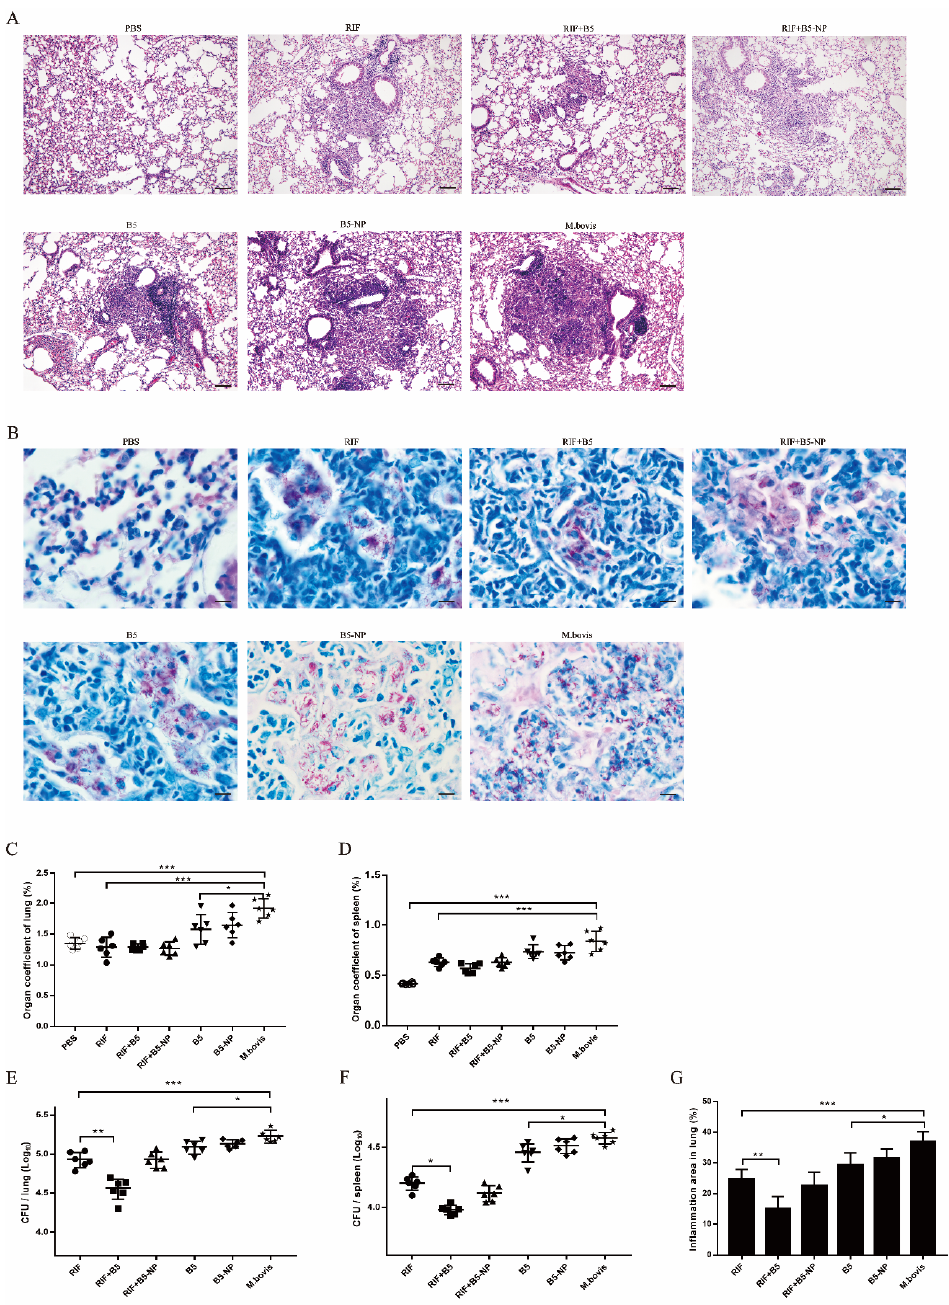
Figure 7. The therapeutic effect of B5 combined with RIF on M. bovis -infected mice. ( A , B ) Histopathological evaluation of lung tissues of M. bovis -infected mice was performed with H&E staining ( A ) and acid-fast staining ( B ) two weeks after treatment with B5, B5-NPs, or combined with rifampicin (RIF), respectively. The top panel ( A ) shows images at ×100 magnification (scale bars, 100 μ m); the bottom panel ( B ) shows images at ×1000 magnification (scale bars, 10 μ m). ( C – F ) The organ coefficient of lung ( C ) and spleen ( D ), and the number of viable bacteria in the lungs ( E ) and spleen ( F ) were determined 2 weeks after treatment. ( G ) Percentage of lung area involved in inflammation lesionsrelativetototallungareausedformorphometric analysis. Data shown are representative of six mice per group. Data collected are expressed as the mean ± SD. (* p < 0.05; ** p < 0.01; *** p <